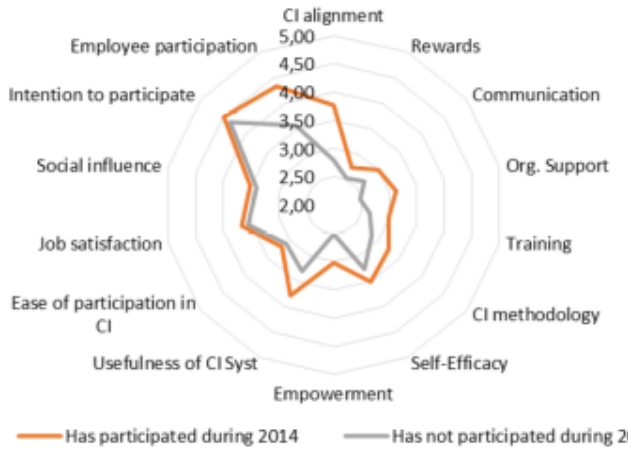
Figure 6. Service case: comparison between participants and non-participants